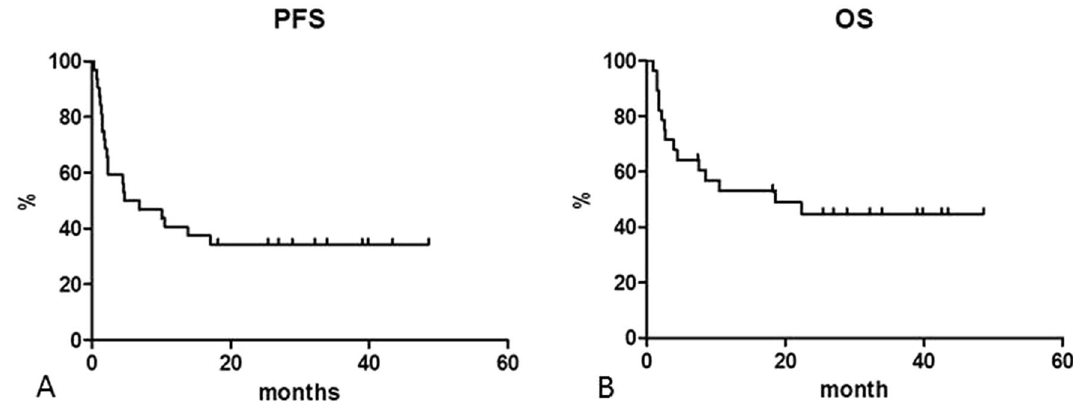
Figure 1. Progression free survival (PFS) ( A ) and overall survival (OS) ( B ).